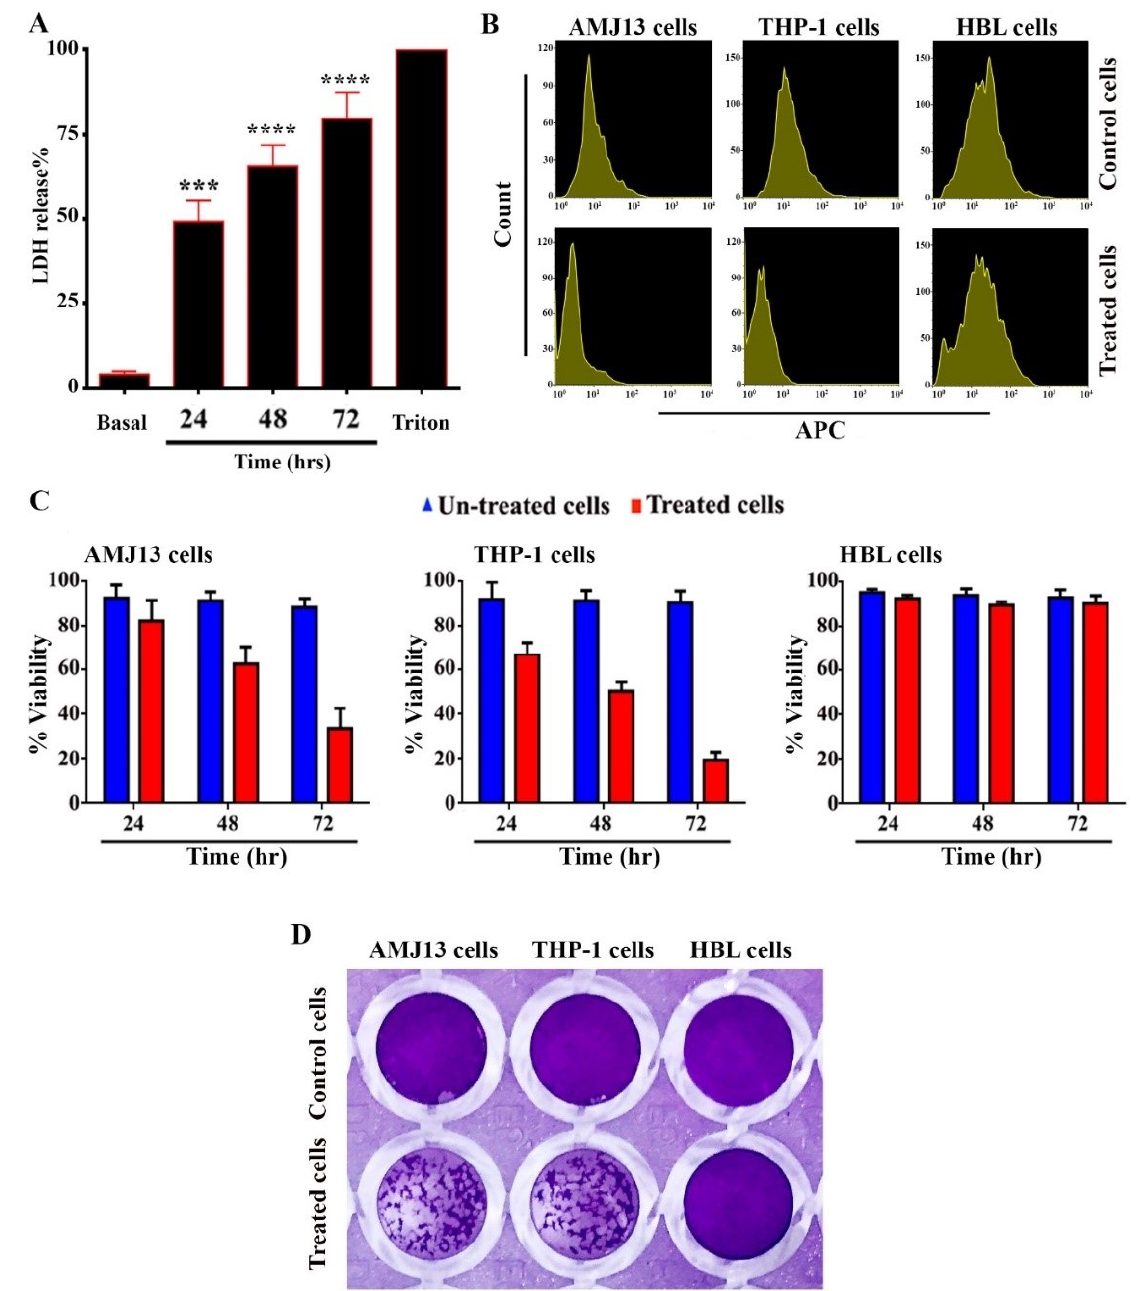
Figure 3. Anti-proliferative activity of AgNPs against AMJ-13 and THP-1 cells. ( A ) AgNPs increase lactate dehydrogenase (LDH) release. The cells were exposed to AgNPs (25 µ g cells mL − 1 for 24, 48, and 72 h). 1% Triton-x was utilized as a positive control. The LDH release activity was measured at 490 nm. Results are represented as mean ± SD *** p < 0.001, **** p < 0.0001. ( B ) Representative proliferation assay by CellTrace™, APC meaning Allophycocyanin. ( C ) Cytotoxic activity of AgNPs against cancer cells in different times. THP-1, AMJ-13, and HBL cells were seeded at a concentration of 1 × 10 5 cells mL − 1 . AgNPs were added in triplicate and incubated for 24, 48, and 72 h. MTT stain was applied to the cells. Following incubation for 3 h at 37 ◦ C. DMSO added to samples. The absorbance was determined at a wavelength of 492 nm. ( D ) Colony-forming unit assay of AMJ-13, THP-1, and HBL cells. Cells were treated with AgNPs at IC 50 (17.34 µ gmL − 1 ) for 24 h, then stained with crystal violet stain for 20